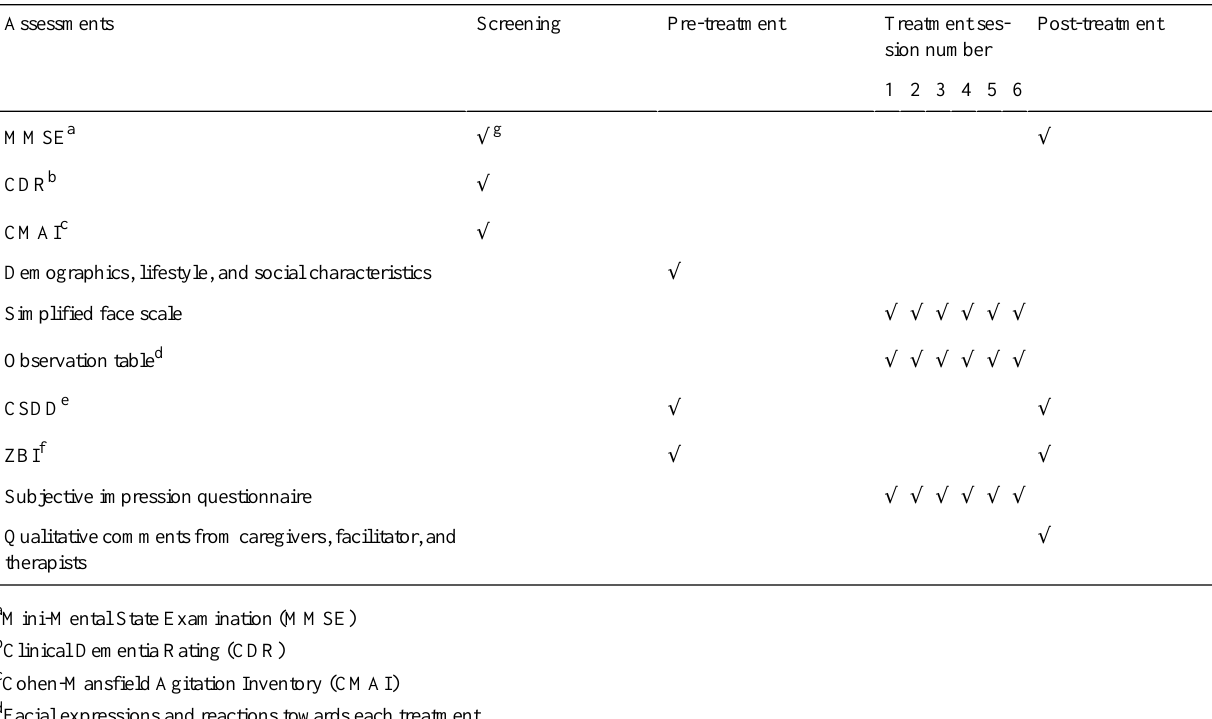
Table 1. Schedule of assessments.